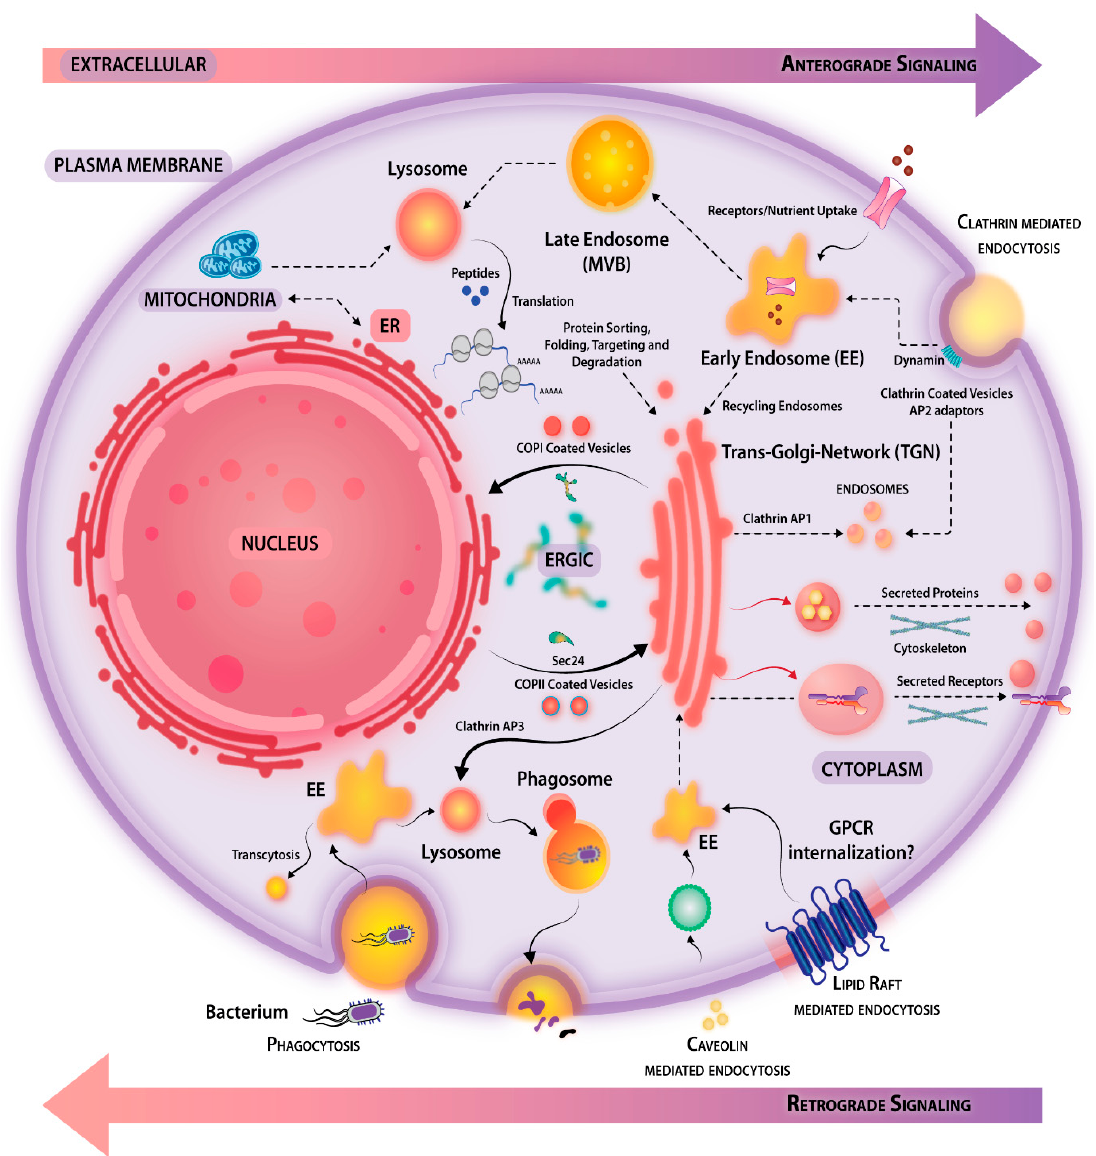
Figure 5. Overview of intracellular vesicular trafficking-cellular organelle rough endoplasmic reticulum (RER) Coat protein I and Coat protein II form vesicles that mediate cargo transport between Golgi to ER and ER to Golgi, respectively. Of the major endocytosis pathways, clathrin-coated vesicles form the early endosomes that mature into late endosomes that subsequently fuse with lysosomes leading to protein recycling. Clathrin, by associating with Adaptor protein (AP) 1 and 2, extends vesicular transport that involves trans-Golgi network. AP3 however, transports proteins to lysosomes and other related organelles. Moreover, receptor endocytosis (GPCR) can occur in clathrin-dynamin-dependent manner. Caveolin also forms endosomal vesicles and joins in the classical endocytic pathway. Phagocytic cells engulf pathogens and effect its lysosomal degradation.